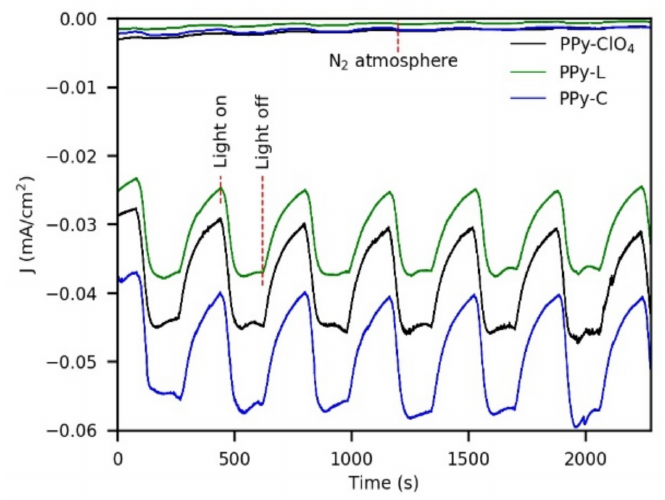
Figure 8. Chopped chronoamperometry of PPy-films in 0.1 M Na 2 SO 4 at − 0.4 V vs. Ag/AgCl (syn- thesis charge of all films was 42 mC/cm 2 ). The notation “N 2 atmosphere” indicates characterizations in deoxygenated